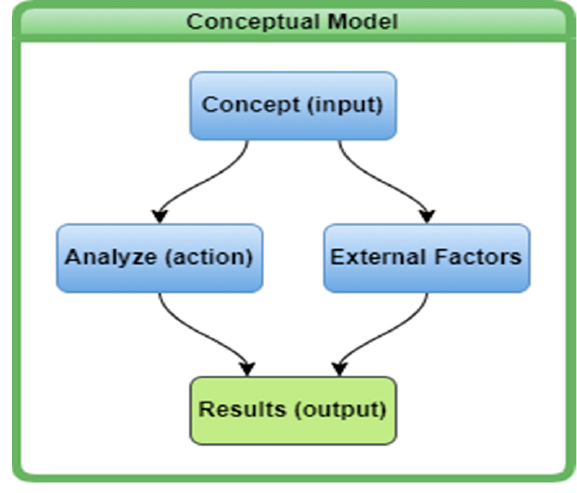
Figure 11. The structure of the conceptual model proposed.